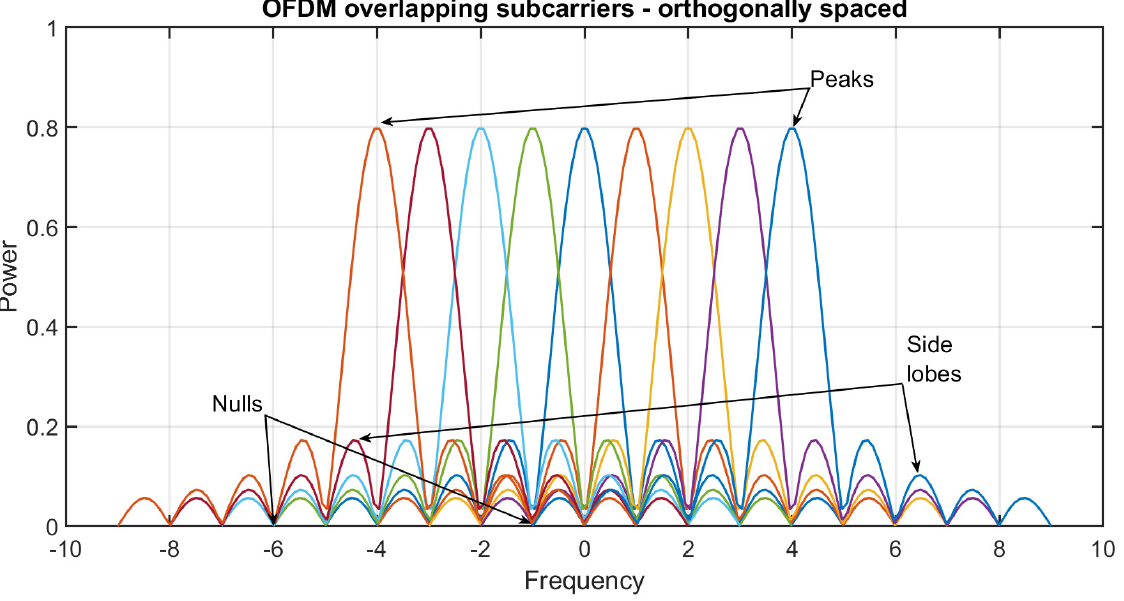
Figure 5. Concept of orthogonality.